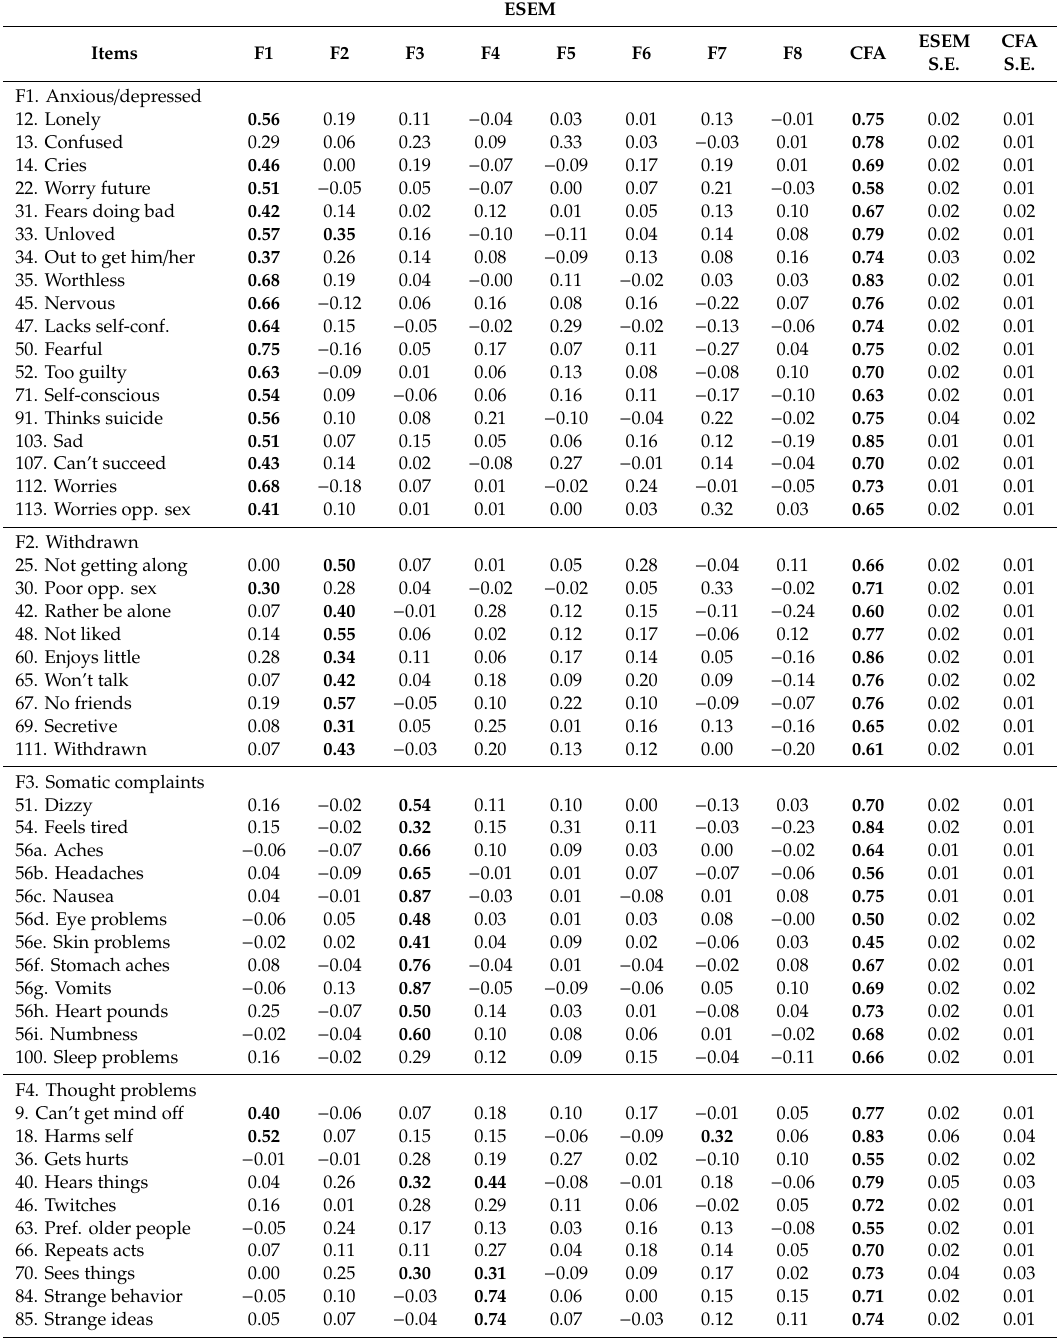
Table 1. Standardized factor loadings and standard errors for CFA and ESEM